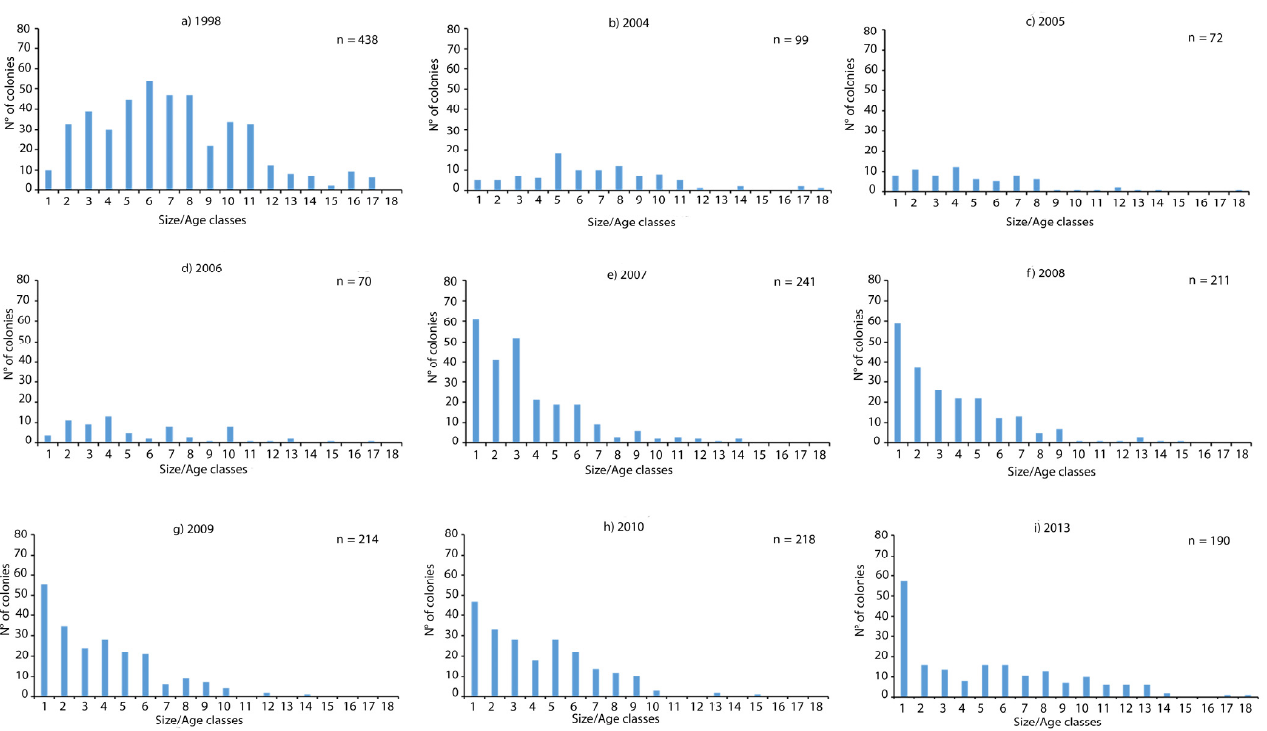
Figure 4. ( a – i ) Population size/age structure during the observational period.